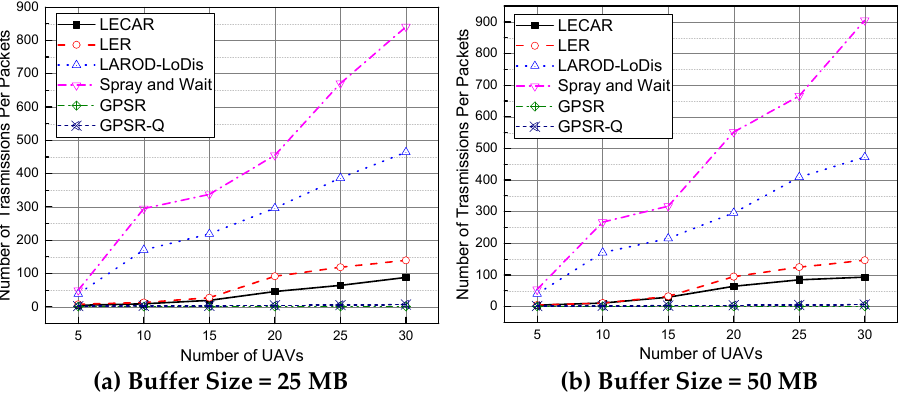
Figure 14. Performance comparison of the routing protocols regarding the number of transmissions per packet when the buffer size is ( a ) 25 MB and ( b ) 50 MB.